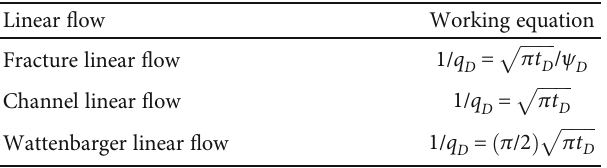
Table 1: Working equation for di ff erent linear fl